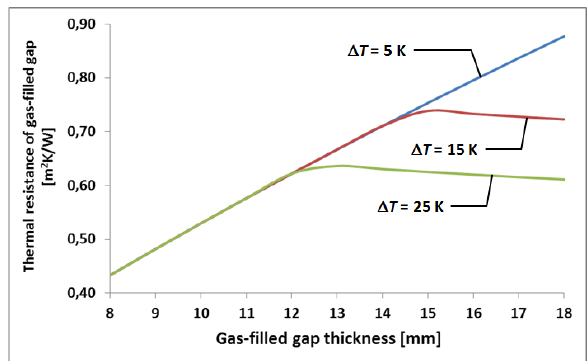
Figure 1: Dependence of thermal resistance of an argon filled gap on its thickness and on temperature difference ∆ T of the limiting surfaces, description provided in the